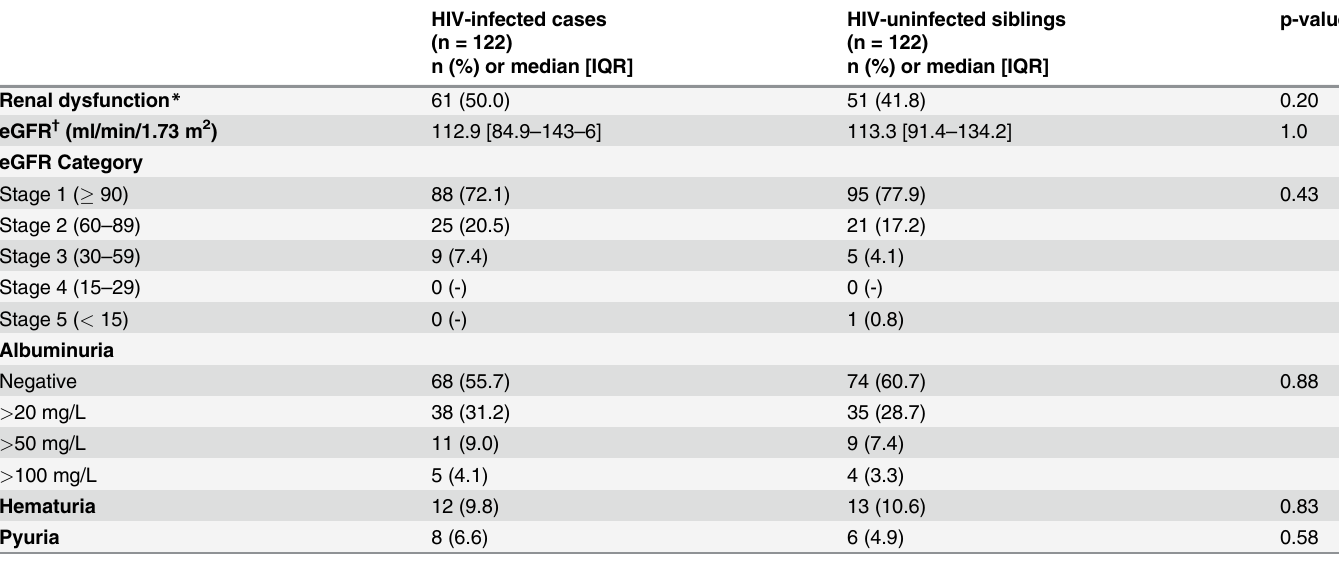
Table 2. Markers of renal dysfunction in HIV-infected children and HIV-uninfected